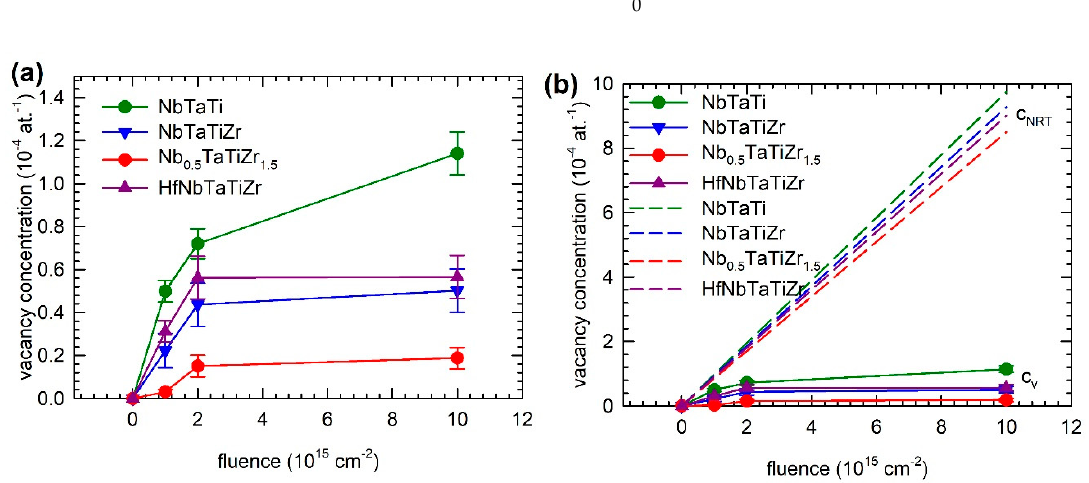
Figure 10. ( a ) The concentration of vacancies estimated from PAS data plotted as a function of fluence. ( b ) Comparison of the average vacancy concentration c NRT “seen” by positrons calculated by SRIM (dashed lines) and the real concentration of vacancies c V determined by PAS (solid lines).